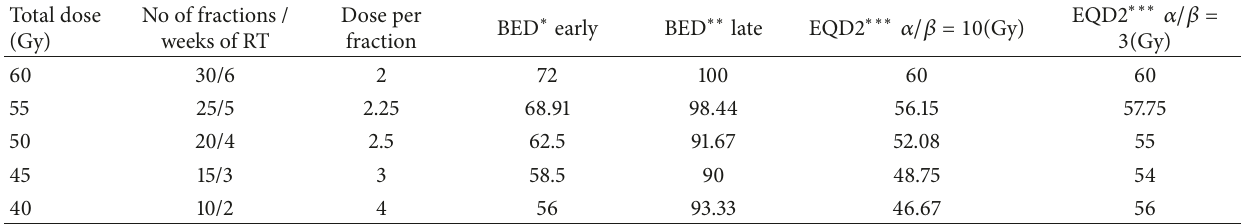
Table 1: Biologically equivalent dose (BED) doses for lentigo maligna.